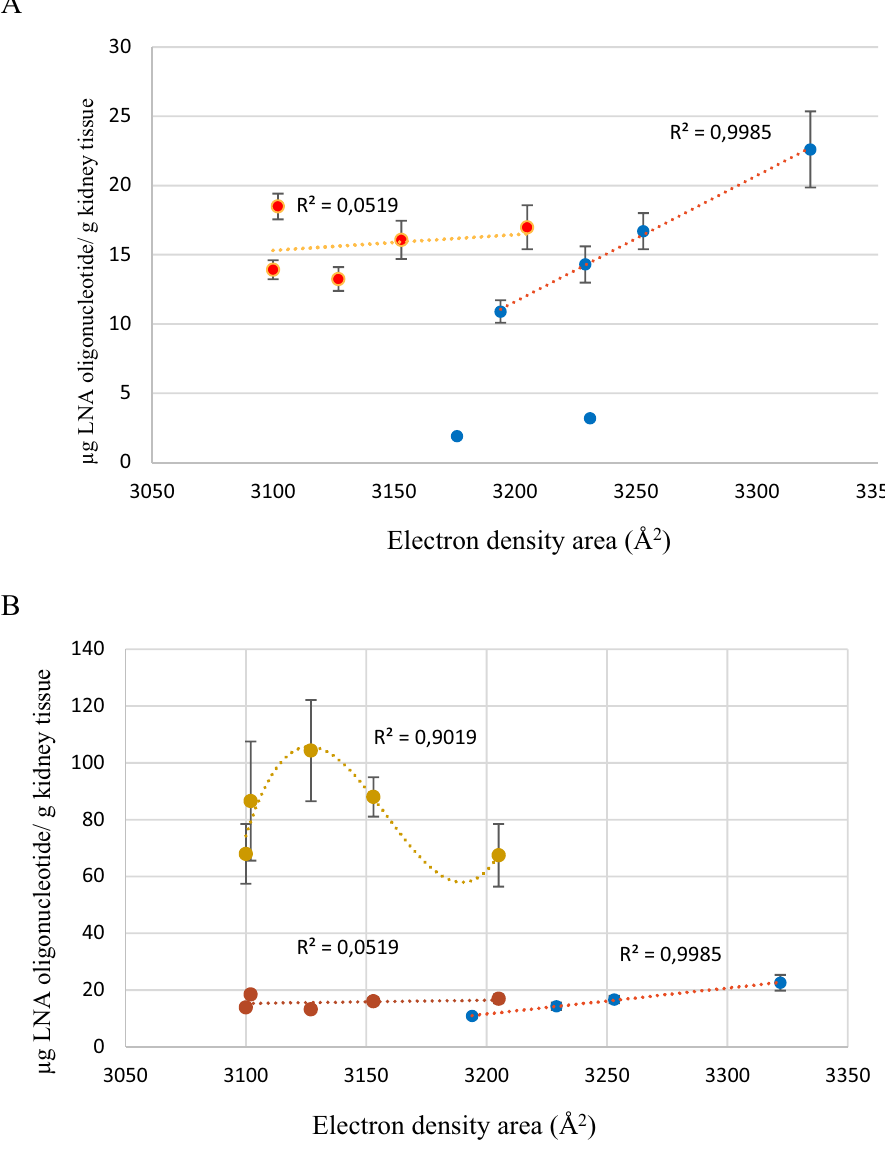
Figure 6. Correlation between electronic density area and kidney uptake in mice (C57BL/6qBom) for all 11 stereo-defined LNAs. Six stereo-defined LNAs against ApoB-100 (blue circles) and five stereo-defined LNAs against Hif-1alpha (green circles). ( A ) Red: Hif-1 alpha. Blue: ApoB-100, all LNAs dosed at 1 mg/kg; ( B ) All ApoB-100 LNAs dosed at 1 mg/kg (blue); all Hif-1 alpha LNAs dosed at 1 mg/kg (red) and 10 mg/kg (yellow). The R 2 values includes measurements of n = 5 mice for liver content for all LNA oligonucleotides. LNA 4 and 6 are not included in the statistics since the measured amount does not represent truly the uptake due to fast 3 ′